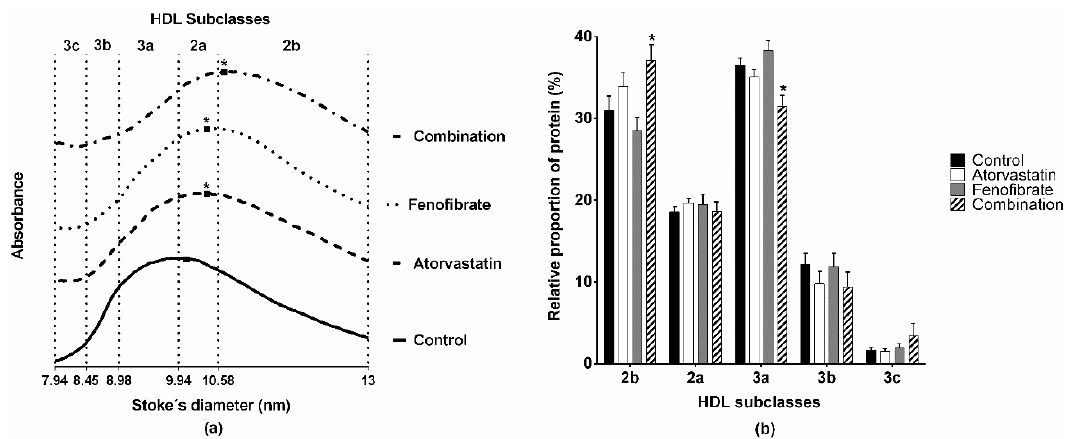
Figure 1. The atorvastatin and fenofibrate combination treatment increased the size of the high-density lipoprotein (HDL) particles. HDL were isolated by ultracentrifugation and separated in subclasses by non-denaturing 3%–30% polyacrylamide gel electrophoresis. The gels were stained for protein and were scanned to obtain the data to construct the graphs. ( a ) Graphs of HDL obtained from control, atorvastatin, fenofibrate, and combination rabbits. n = 6. Arbitrary absorbance units are plotted on the vertical axis. ( b ) The relative HDL size distribution estimated from graphs. The total area under the curve was considered as 100% and the partial areas between the intervals as relative percentages of HDL subclasses. Data are mean ± standard error. n = 6. * ANOVA test, p < 0.05 vs. control rabbits. Table 2. Cholesterol, triglycerides, and phospholipids plasma concentrations of HDL subclasses. Control Atorvastatin Fenofibrate Combination HDL Subclasses n = 6 n = 6 n = 6 n = 6 C ( µ mol /